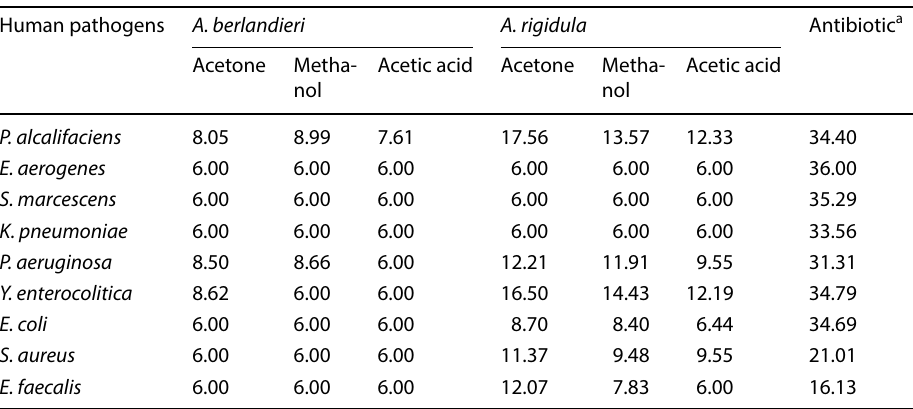
Table 1 Average zone of inhibitions (mm) of leaf extracts of A. berlandieri and A. rigidula